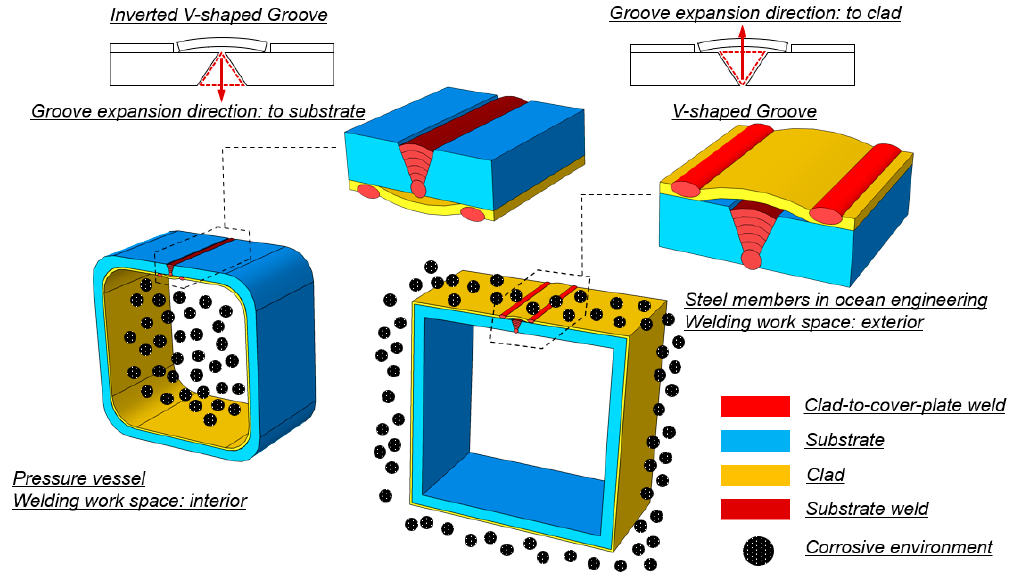
Figure 3. The groove nature of TC bimetallic steel weld joints utilized in ocean building engineering.